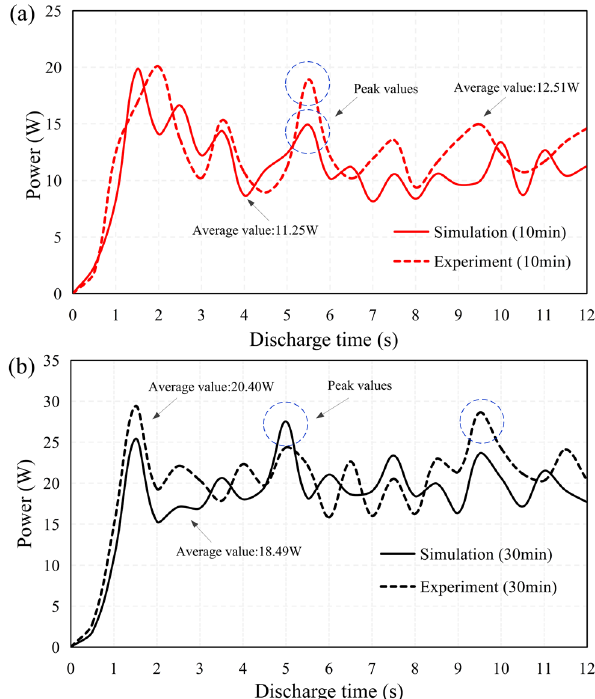
Figure 19: In fl uence of concrete fl ow characteristics on driving power at di ff erent batch times: ( a ) 10 min and ( b ) 30